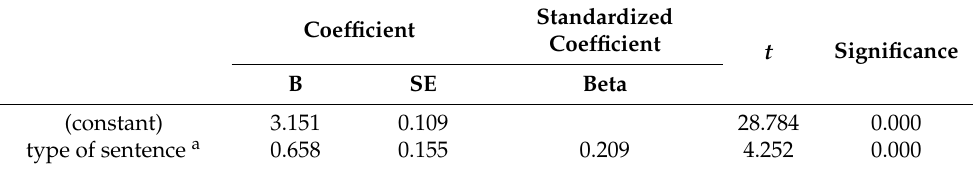
Table 6. Result of Study A3.